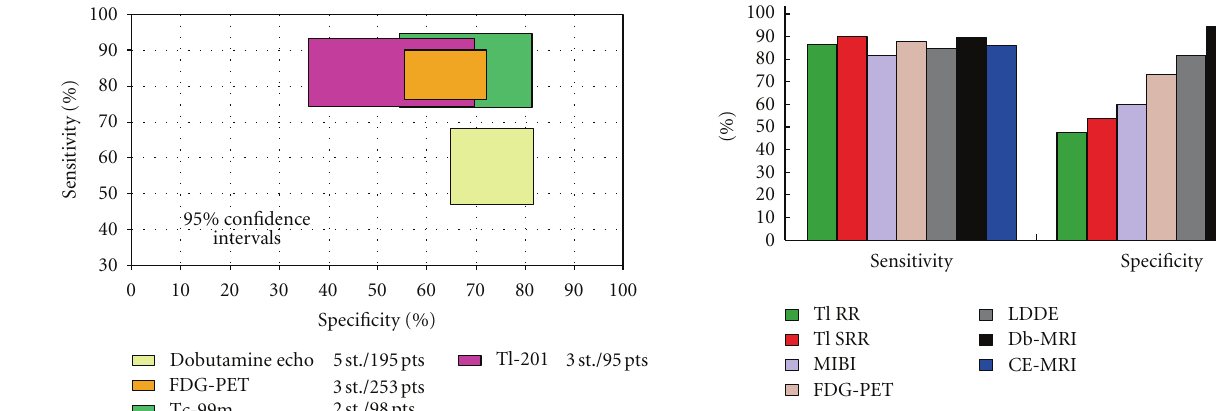
Figure 2: Comparison of sensitivities and specificities with 95% confidence intervals of the various techniques for the prediction of recovery of global LV function after revascularization (with permission from Schnikel et al. [103]).